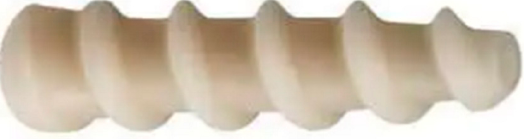
Figure 3. Tibial tunnel interference screw (DePuy Mitek MILAGRO BR).